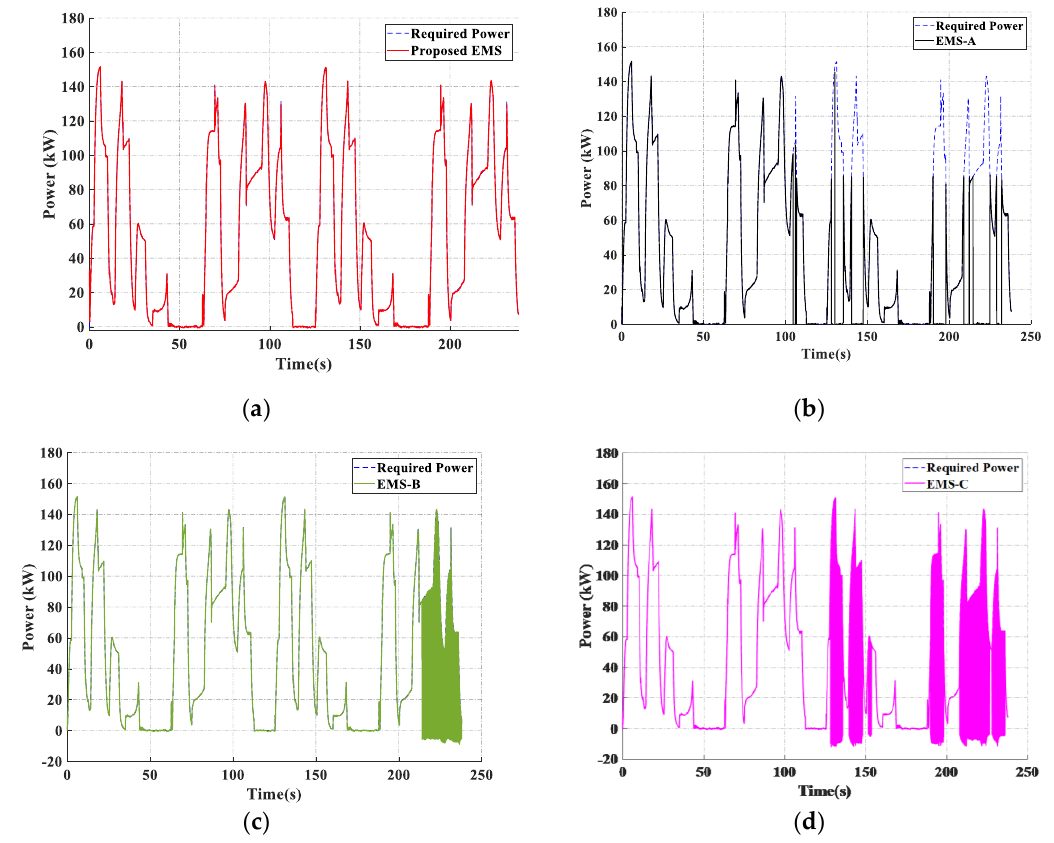
Figure 16. Power response from FC / BAT / SC sources in the proposed case and conventional cases. ( a ) Proposed EMS; ( b ) EMS-A; ( c ) EMS-B; ( d )